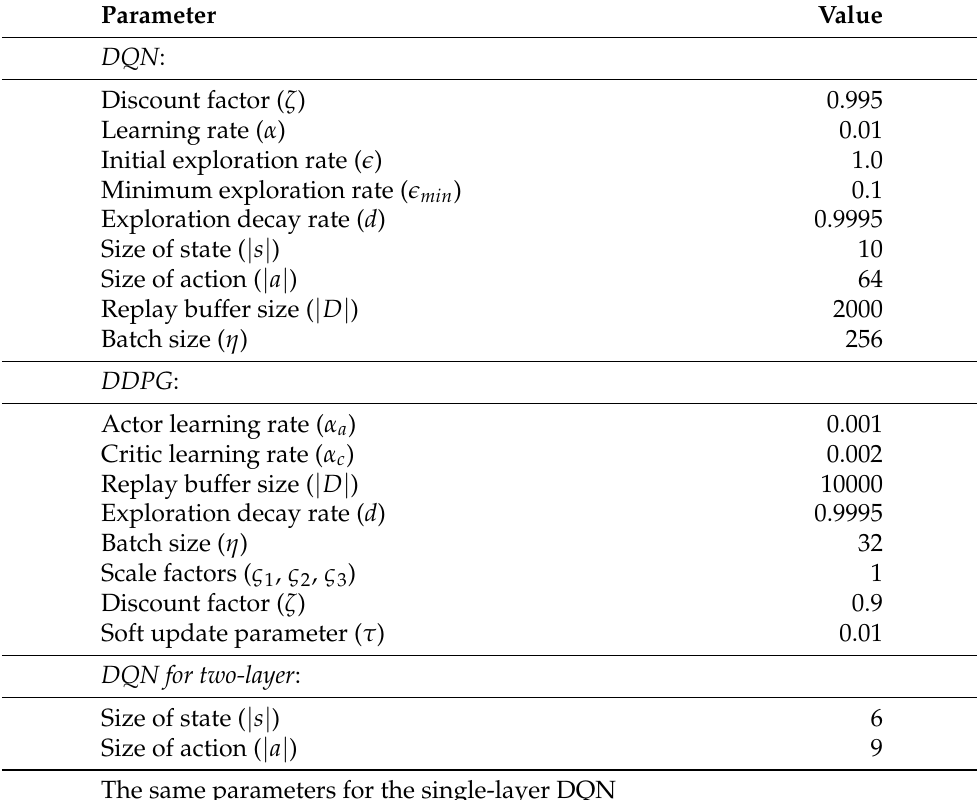
Table 2. Reinforcement learning